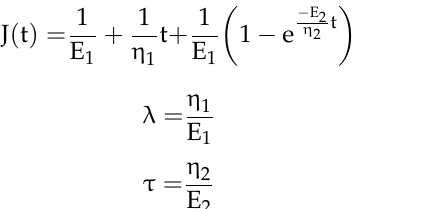
Table 13. Burgers model parameter results at different